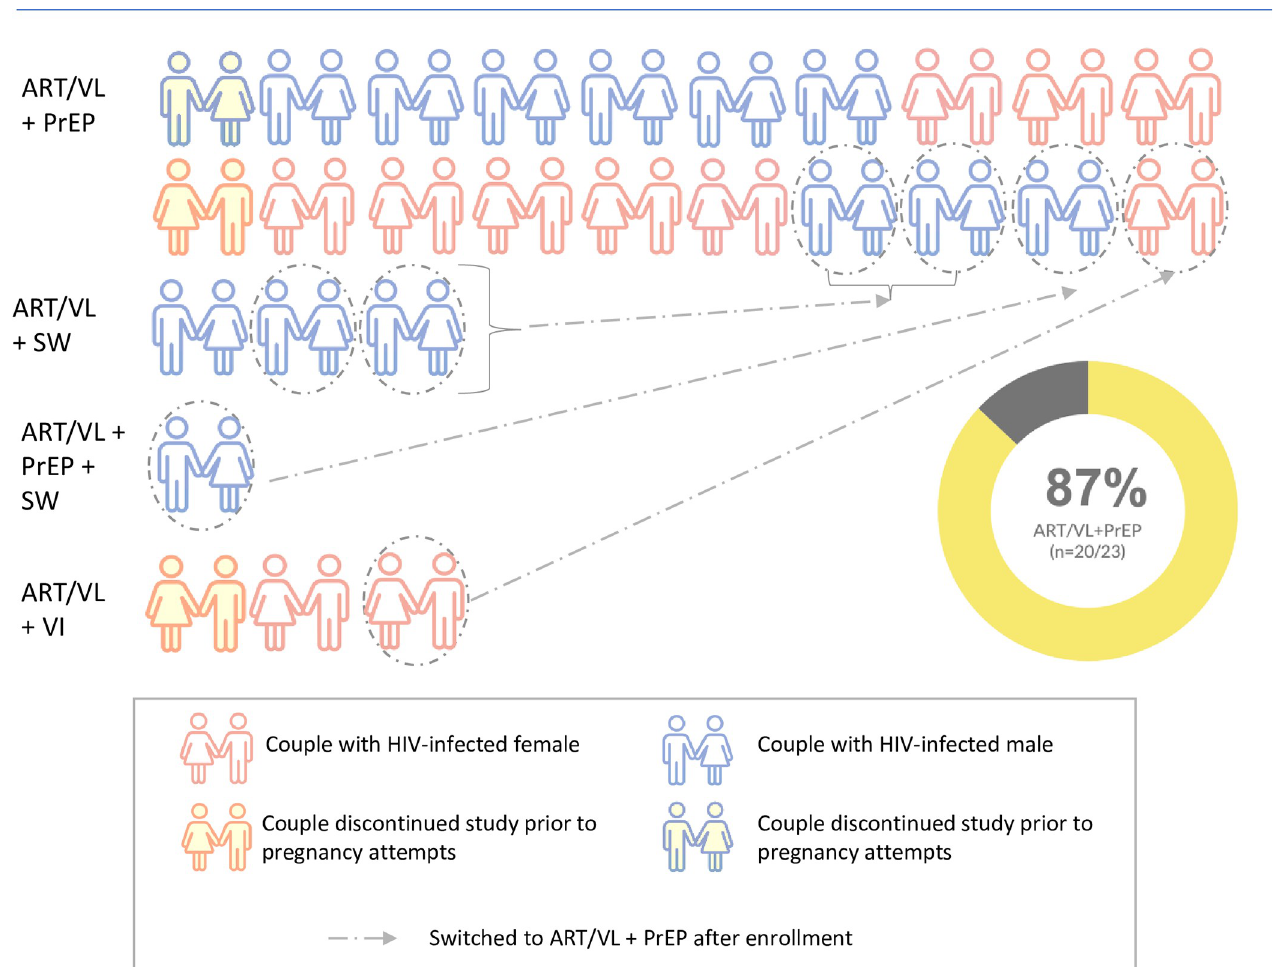
Fig 7. Safer conception method uptake at enrollment and switching during follow-up. ART/VL = antiretroviral therapy (ART) with monthly viral load (VL) monitoring; PrEP = pre-exposure prophylaxis, VI = vaginal insemination; SW = semen washing.